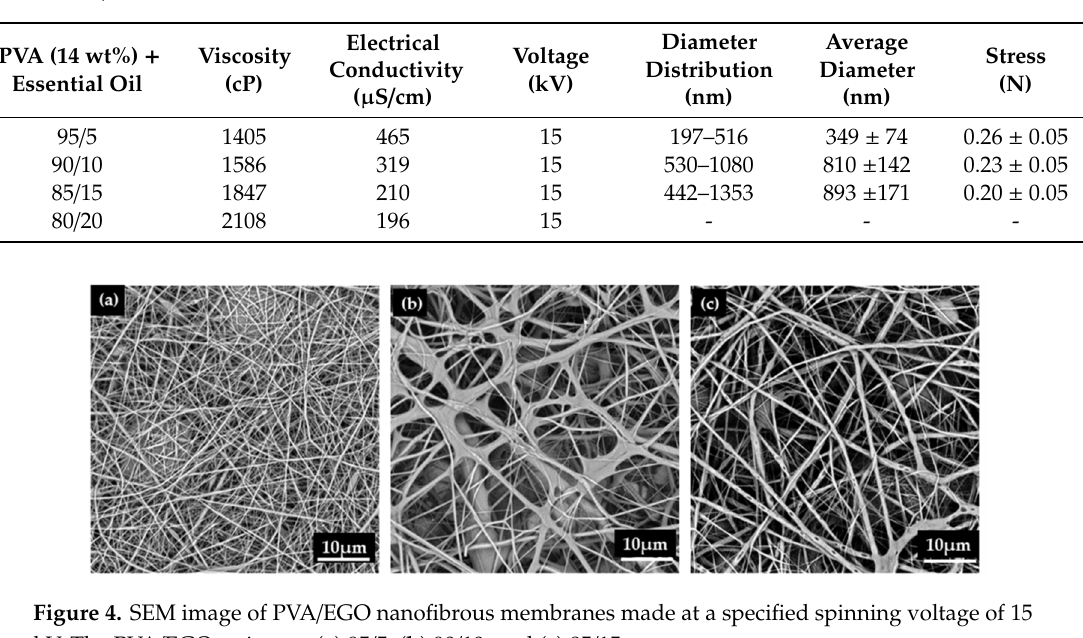
Table 2. Physical properties of PVA/ Eucalyptus globules oil (EGO) solutions and diameter distribution of PVA/EGO nanofibrous membranes.